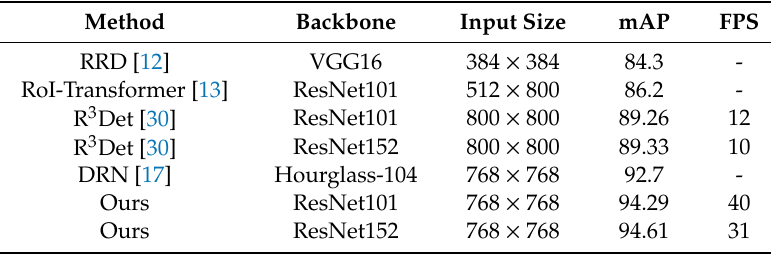
Table 2. Accuracy and speed comparison on HRSC2016. FPS: frames per second.